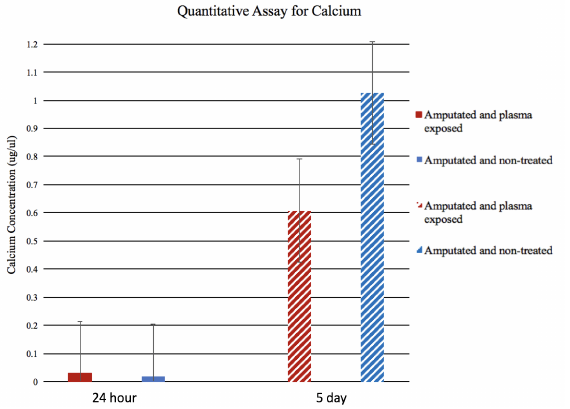
Figure 5. Quantitative Ca 2 + estimation: At 24 h post amputation, wound epithelium (WE) of experimental and control tadpoles show lower Ca 2 + content, whereas, in day 5, blastema Ca 2 + content in both groups was much higher. The changes were insignificant between the two